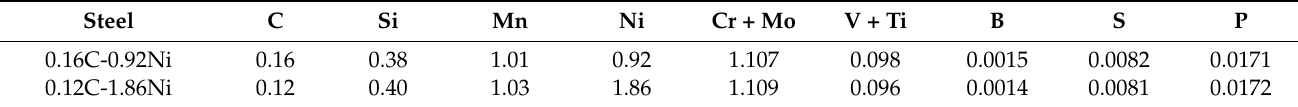
Table 1. Chemical composition of the studied steels